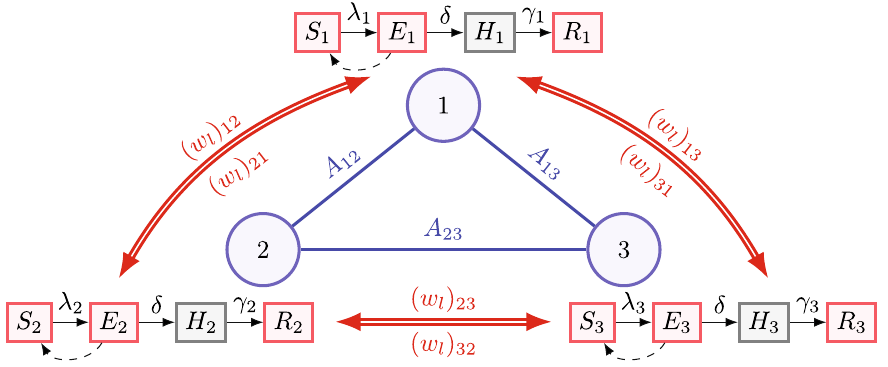
Figure 1. A diagram illustrating the model proposed in this paper. The example includes three regions, marked by circles in blue and indexed by 1, 2, and 3. For k , j ∈ { 1, 2, 3 } and k = j , A kj on the edge ( k , j ) represents the similarity between regions k and j . The square nodes associated with each region denote the compartments for each region, including susceptible, exposed, hospitalized, and removed compartments. The arrows connecting square nodes denote the transition between compartments in each region, and the details can be found in “Model description”. Note that (cid:31) 1 , (cid:31) 2 , and (cid:31) 3 , the transmission parameters in the three regions, are allowed to be spatially heterogeneous. The double arrows in red denote the transportation between three regions on the l -th day. For k , j ∈ { 1, 2, 3 } ( k = j ), ( w l ) kj represents the total transportation volume from region k to region j on the l -th